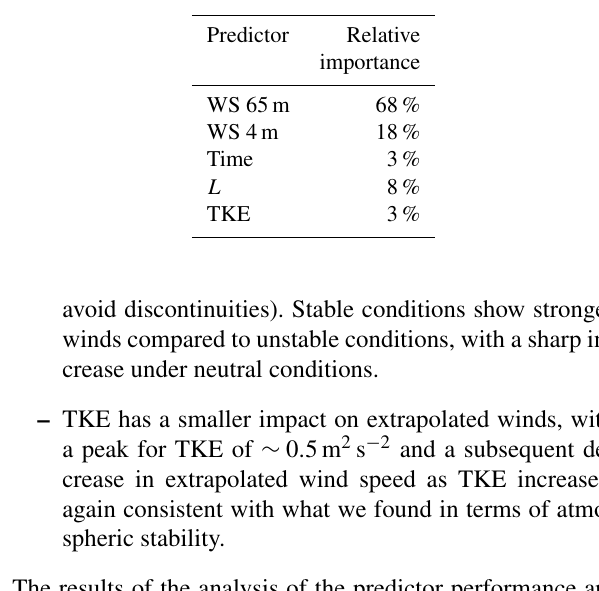
Table 5. Predictor importance for the random forest used to extrap- olate winds at 143ma.g.l. at site C1. WS denotes wind